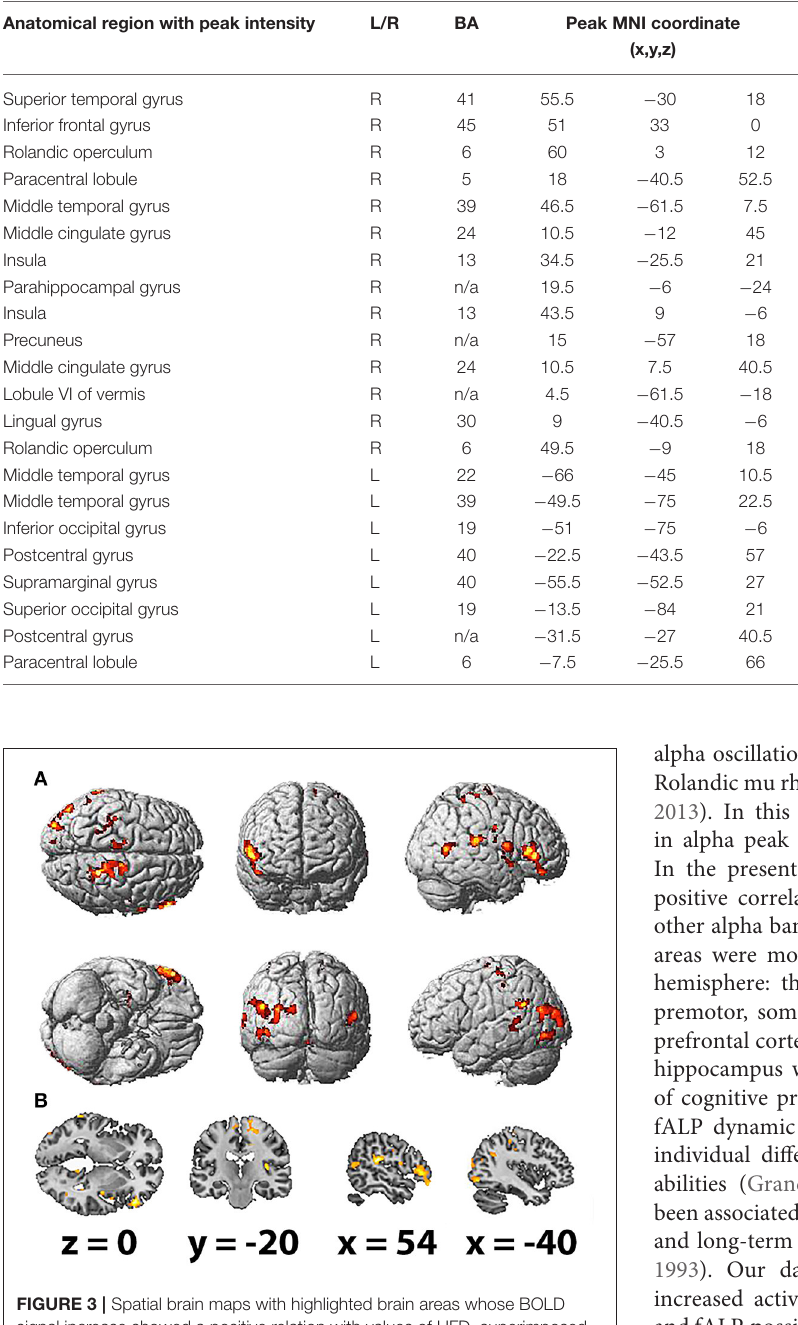
FIGURE 3 | Spatial brain maps with highlighted brain areas whose BOLD signal increase showed a positive relation with values of HFD, superimposed on (A) normalized surface in three projections and (B) the scalp-stripped version of the average T1-weighted template image at the three most informative orthogonal slices in neurological convention (left = right). Activation ( p < 0.001 uncorrected, T < 3.47, cluster threshold > 100) is displayed in a gradient from red to yellow (3 < t <